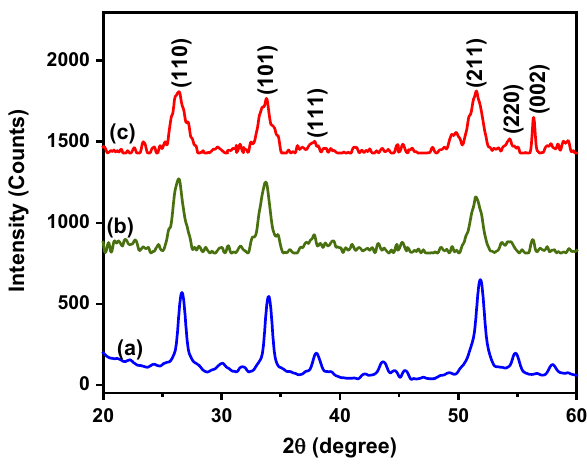
Fig. 1 XRD patterns of (a) SnO Y-doped SnO 2